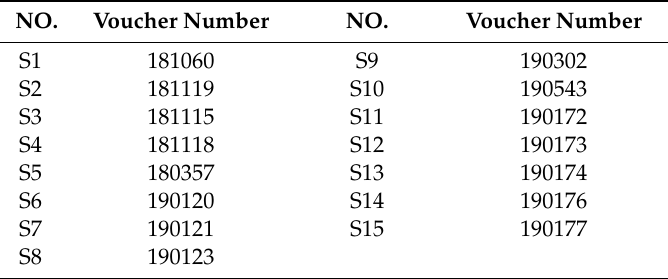
Table 11. Information on the fifteen batches of samples.